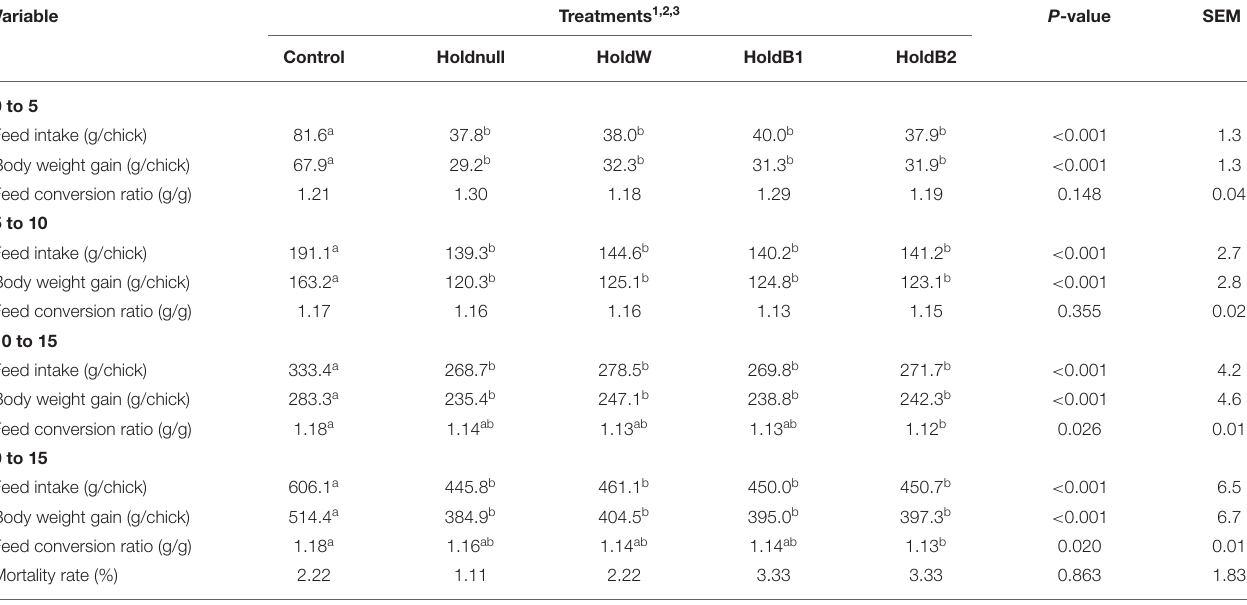
TABLE 3 | Effect of betaine supplementation in drinking water on the live performance of broiler chicks held for 48h post-hatch.